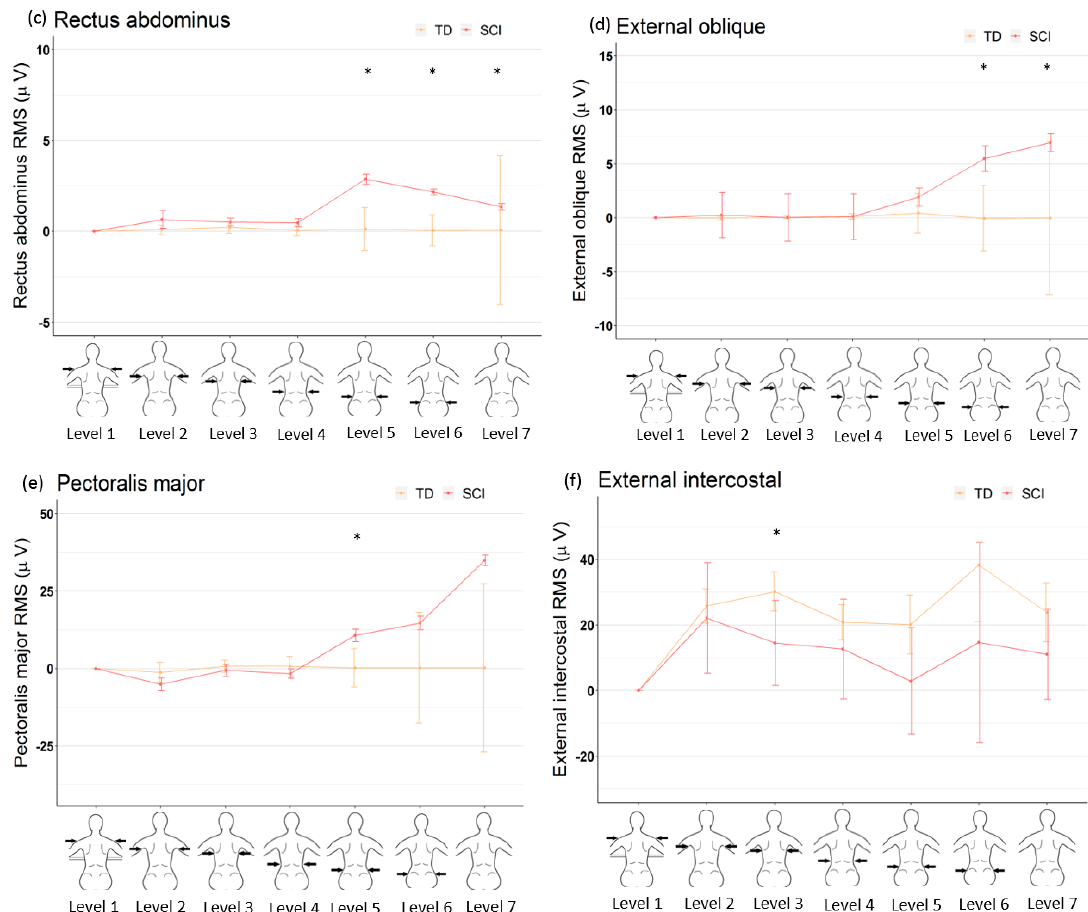
Figure 2. Comparison of trunk muscle activation during different SATCo support levels between children with spinal cord injury and typically developing children. Electromyography (EMG) data is represented as median of root mean square (RMS) values and standard error of median (SEM) bars of trunk muscles. ( a ) Thoracic paraspinal (PST), ( b ) Lumbar paraspinal (PSL), ( c ) Rectus abdominus (RA), ( d ) External oblique (OB), ( e ) Pectoralis major (PEC), and ( f ) External intercostal (INT) muscle.1 = shoulder level, 2 = Axilla, 3 = inferior scapula, 4 = over lower ribs, 5 = below ribs, 6 = pelvis, 7 = no support. ✽ Indicates significant differences in root mean square values between the two groups. Table 3. Root mean square (RMS) values of trunk muscles during SATCo assessment in typically developing children and in children with spinal cord injury.